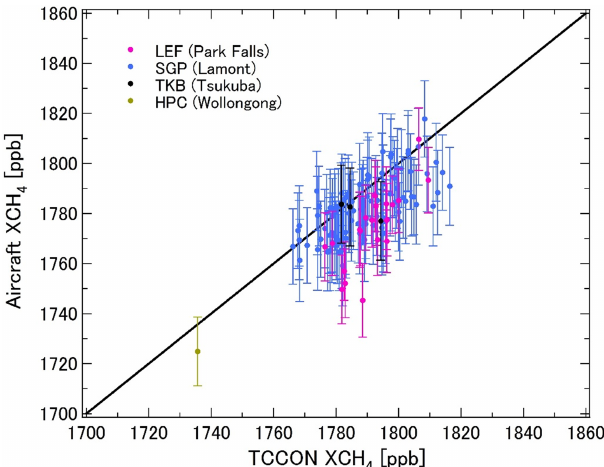
Figure 12. Scatter diagram between aircraft-based XCH 4 observed within ± 5 ◦ latitude–longitude boxes centered at each TCCON site and TCCON XCH 4 (GGG2012 release) on the same day as aircraft measurement at each site. The black lines show one-to-one corre-